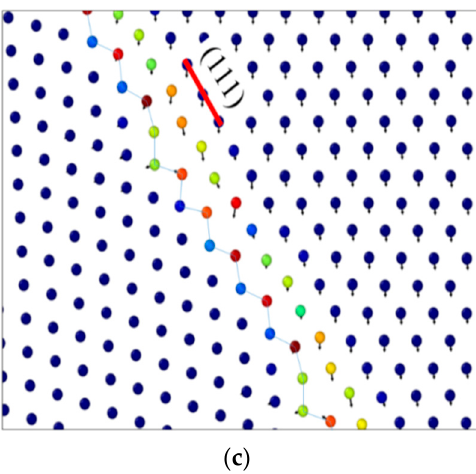
Figure 9. Atomic configuration during the indentation near ( Δ x = R ) the loose GB at δ = 0.85 nm. Atoms are colored according to CSP; x , y , and z axes of the simulation cell are respectively aligned with lattice directions (cid:4670)110(cid:4671) A , (cid:4670)1(cid:3364)10(cid:4671) A , and (cid:4670)001(cid:4671) A . ( a ) 3D view. fcc atoms are removed for the clarity of illustration; ( b ) cross-sectional view. Atoms on two adjacent (cid:4666)22(cid:3364)0(cid:4667) planes at the center of the bicrystal are shown along the (cid:4670)11(cid:3364)0(cid:4671) tilt axis; and ( c ) the magnified view of the region marked with the dashed square in ( b ).